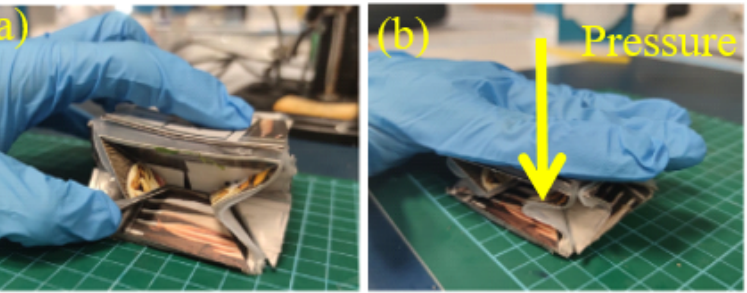
Figure 3. The passively linear motion of our origami structure. ( a , b ) show that this origami structure generates the linear motion when normal pressure is manually